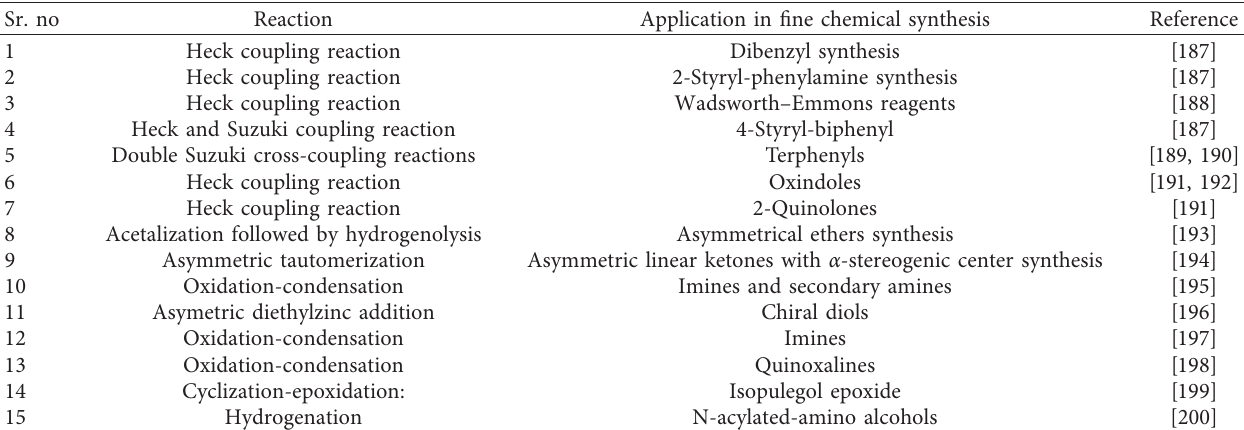
Figure 13: Illustration of COVID-19 antibody containing lipid nanoparticle containing the mRNA. Table 9: Synthesis methods using palladium as